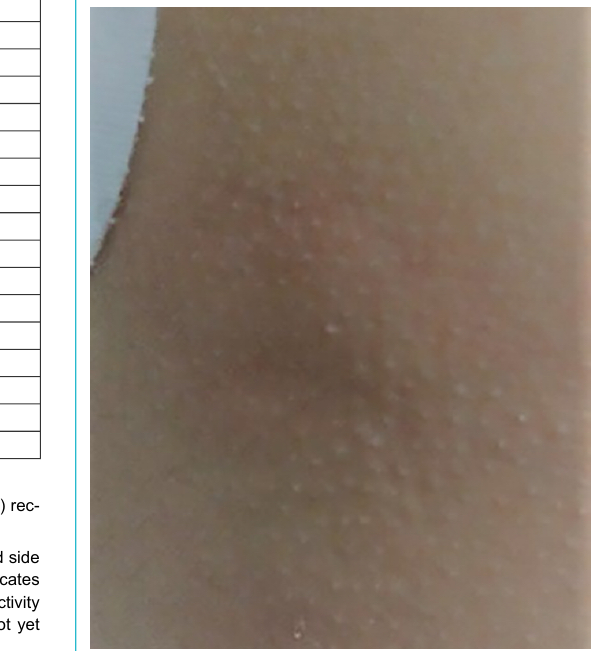
Figure 1: Urticarial rash typical of an immediate hypersensitivity reaction few minutes after intravenous administration of hydrocorti- sone 50